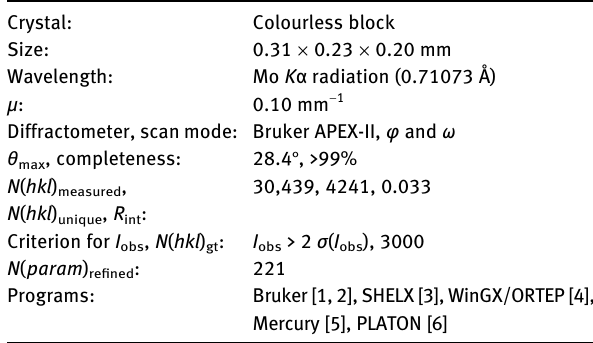
Table  : Data collection and